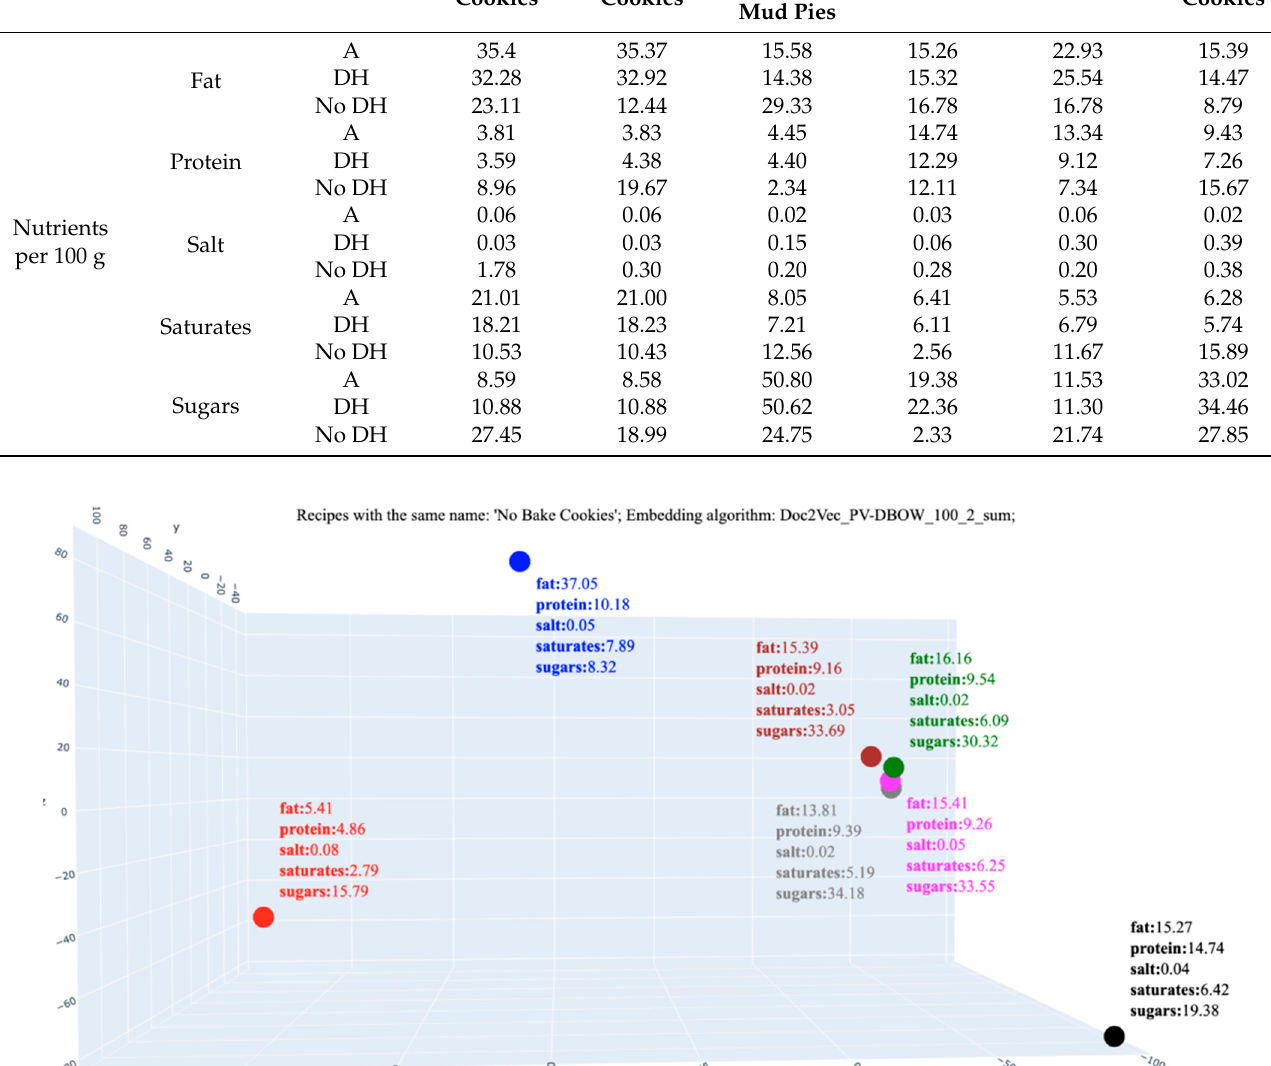
Figure 5. Visual representation of the vector representations without the domain-specific heuristic of a group of recipes with the same name.